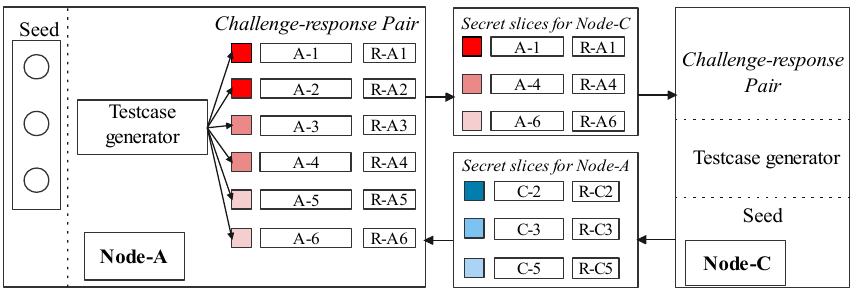
Figure 6. Building and sharing secret